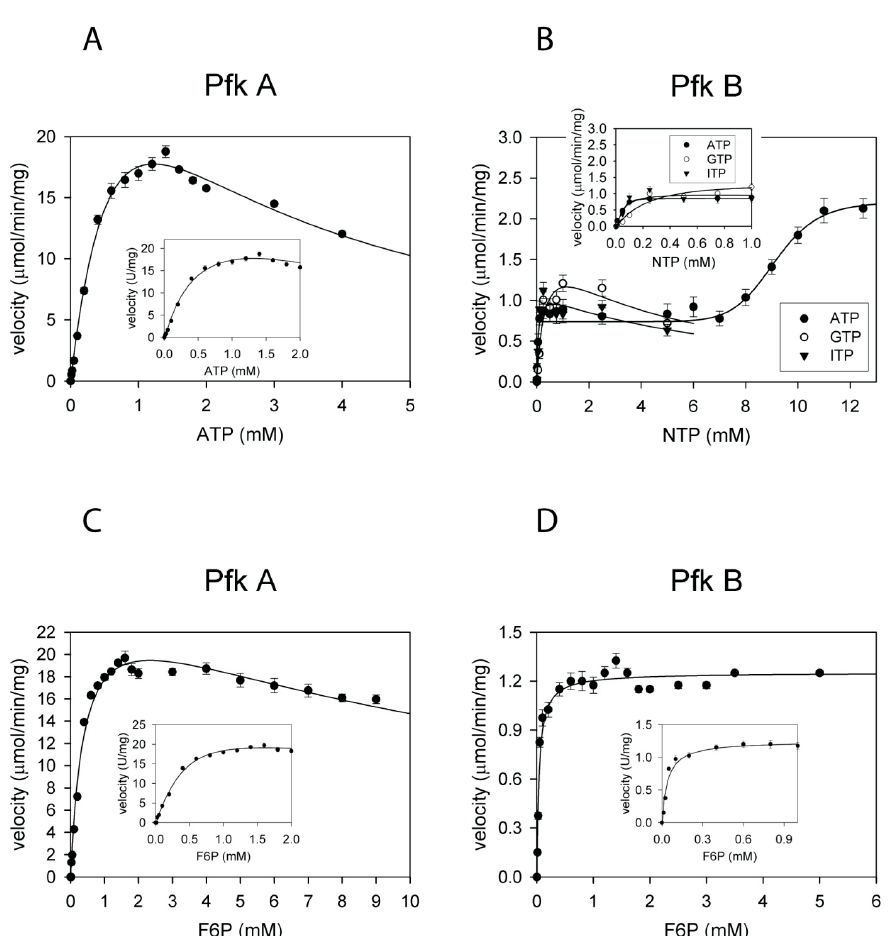
Figure 1. Influence of nucleoside triphosphate (NTP) concentration on glycolytic activities of phosphofructokinase (Pfk) A and Pfk B. Dependencies of Pfk A ( A ) and Pfk B ( B ) reaction velocities on NTP concentration. The concentration of F6P was kept at 1 mM while the concentration of NTPs varied between 0–12 mM. Error bars are standard deviations. Influence of F6P concentration on glycolytic activities of Pfk A and Pfk B. Dependencies of Pfk A ( C ) and Pfk B ( D ) activities on increasing fructose-6-phosphate (F6P) concentrations. The concentration of F6P varied between 0–10 or 0–6 mM while the concentration of ATP was fixed at 1 mM. Error bars are standard deviations. The data in panel ( A ) were fitted to Equation (4), in panel ( B ) to Equations (3) and (4), in panel ( C ) to Equation (4), and in panel ( D ) to Equation (1).